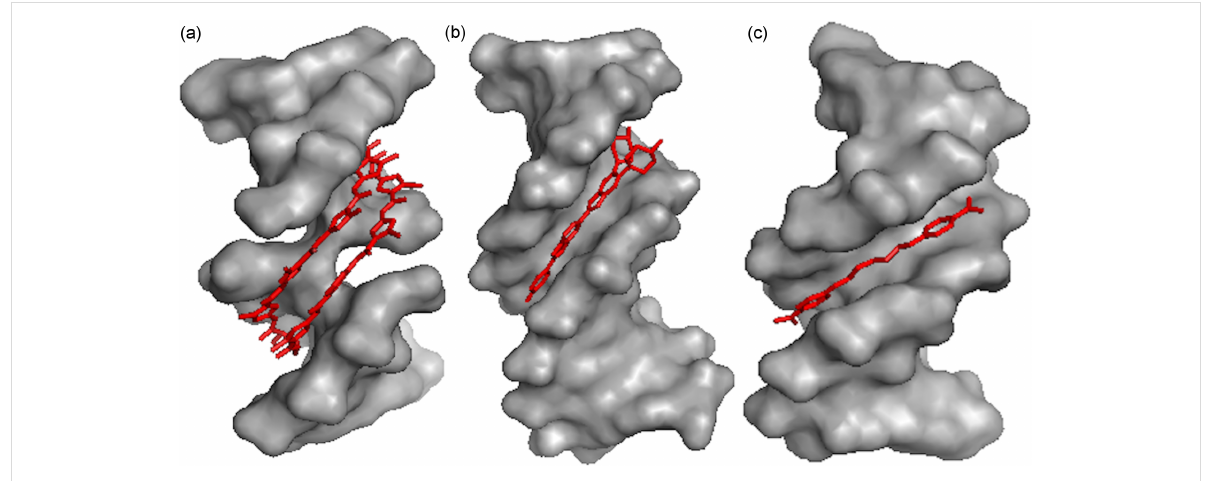
Figure 7: (a) Minor groove complex formation between DNA duplex and 8-ring cyclic Py/Im polyamide (conjugate 17, PDB ID# 3I5L) [76]; (b) Complex between DNA duplex and Hoechst 33258 (PDB ID# 8BNA) [82]; (c) Crystal complex between DNA duplex and pentamidine (PDB ID# 3EY0)